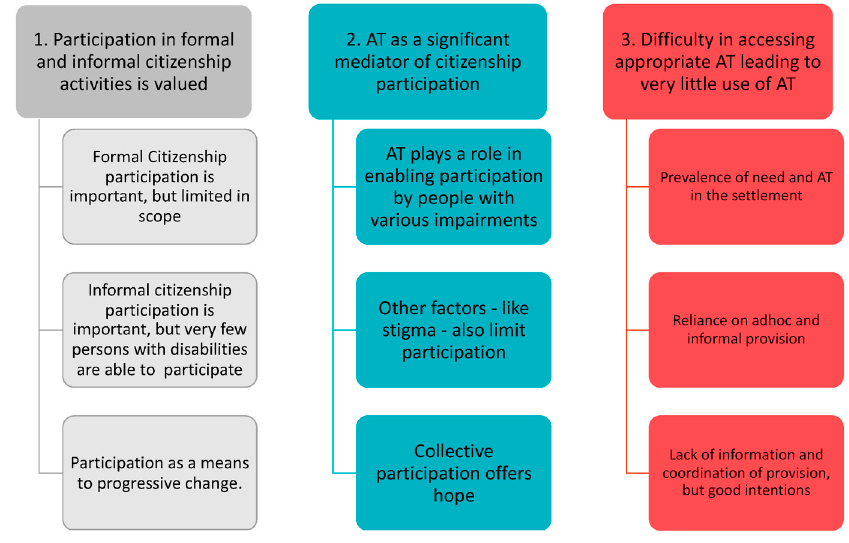
Figure 2. Thematic Framework of key themes and